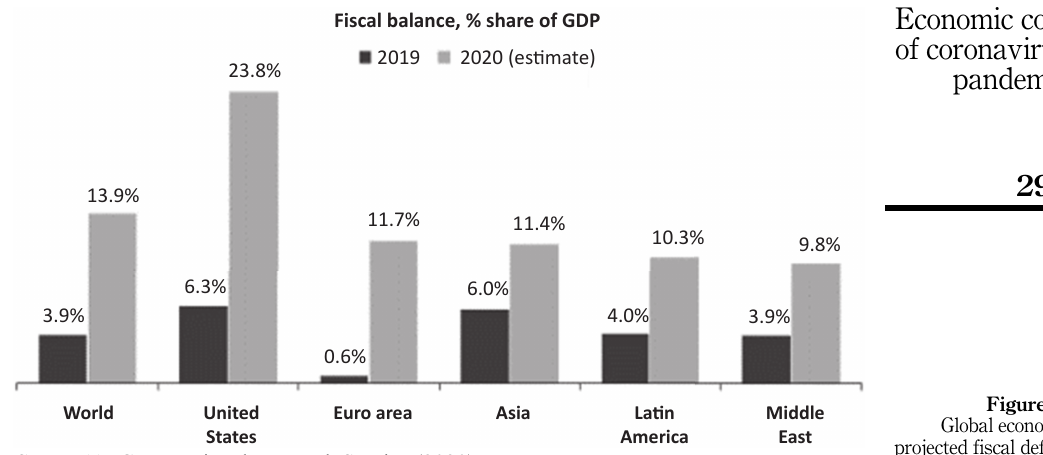
Figure 5. Global economy